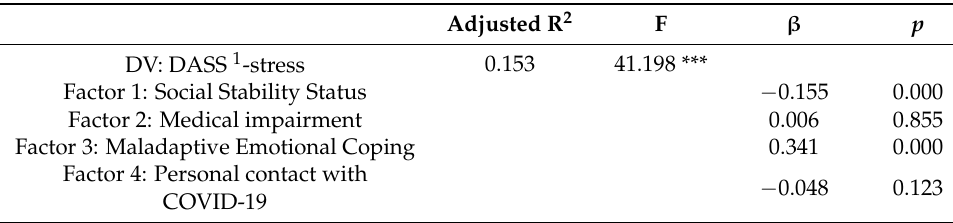
Table 4. Regression